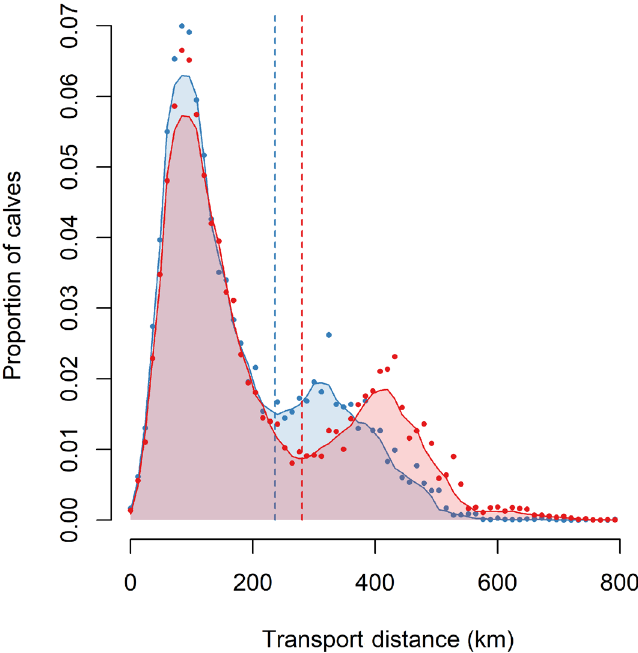
Figure 1. Distribution of the historical (red) and optimised (blue) transport distances. The dots represent frequencies of discrete classes of same size and the curves are obtained by smoothing of these frequencies (running median) The dashed vertical lines correspond to the two third of their respective distributions, used to separate short from long